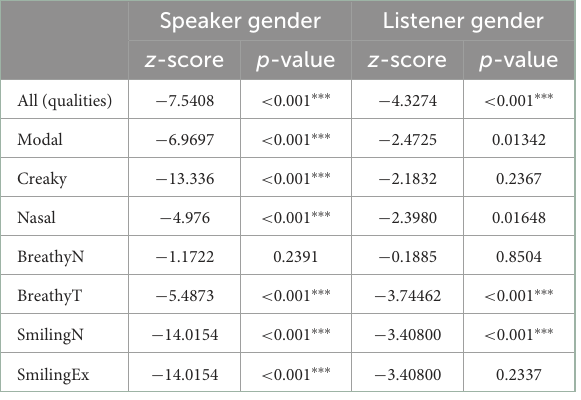
TABLE 3 Results of the Wilcoxon signed-rank pairwise significance test ( z -values and p -values) for each examined vocal quality and aggregated over all vocal